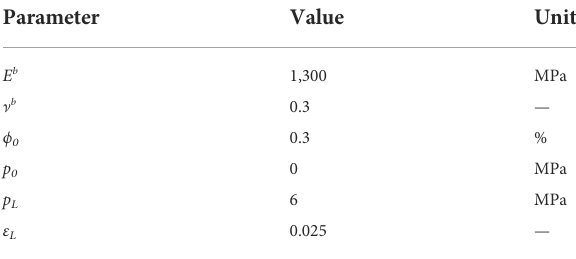
TABLE2Parametervaluesusedformodelvalidationofpermeabilityof cylinder